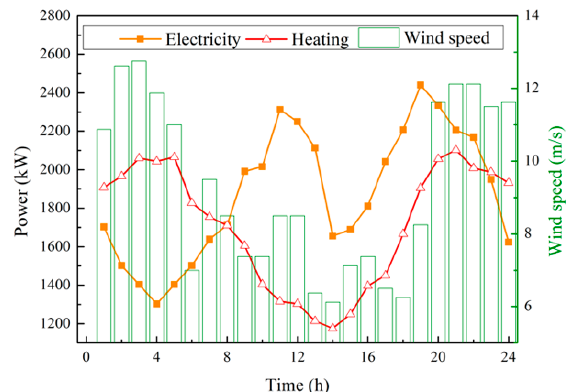
Figure 5. Inputting data in summer.